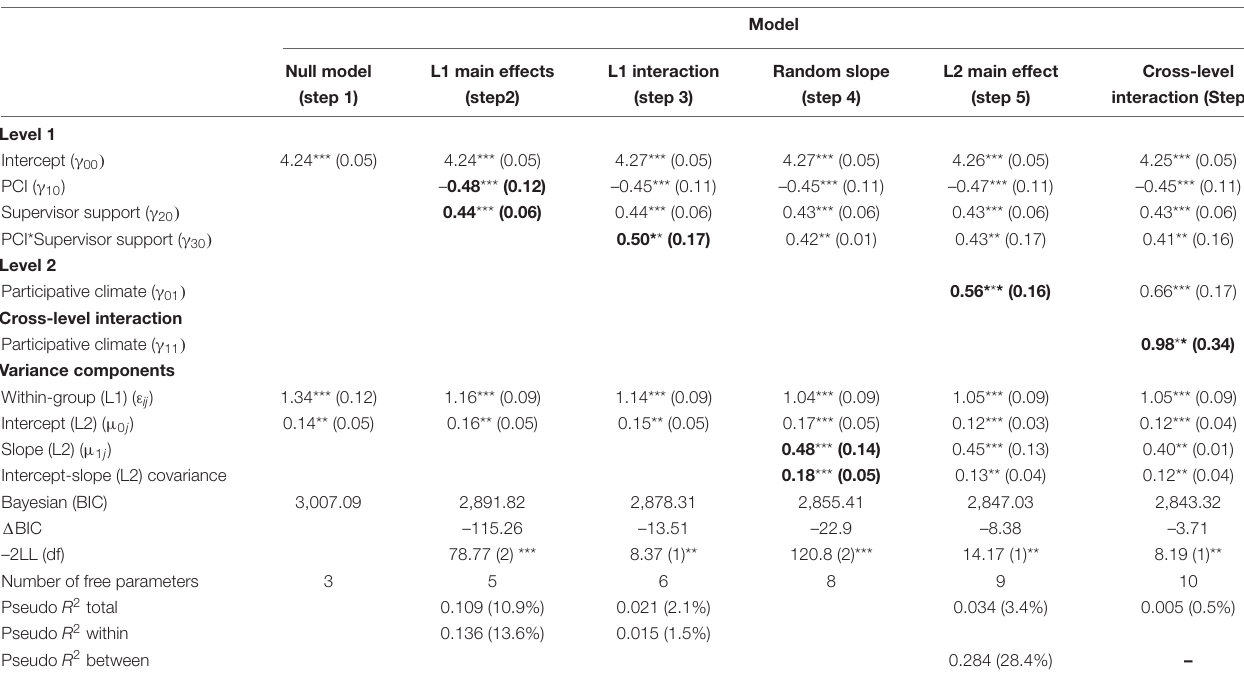
TABLE 2 | Results of multi-level